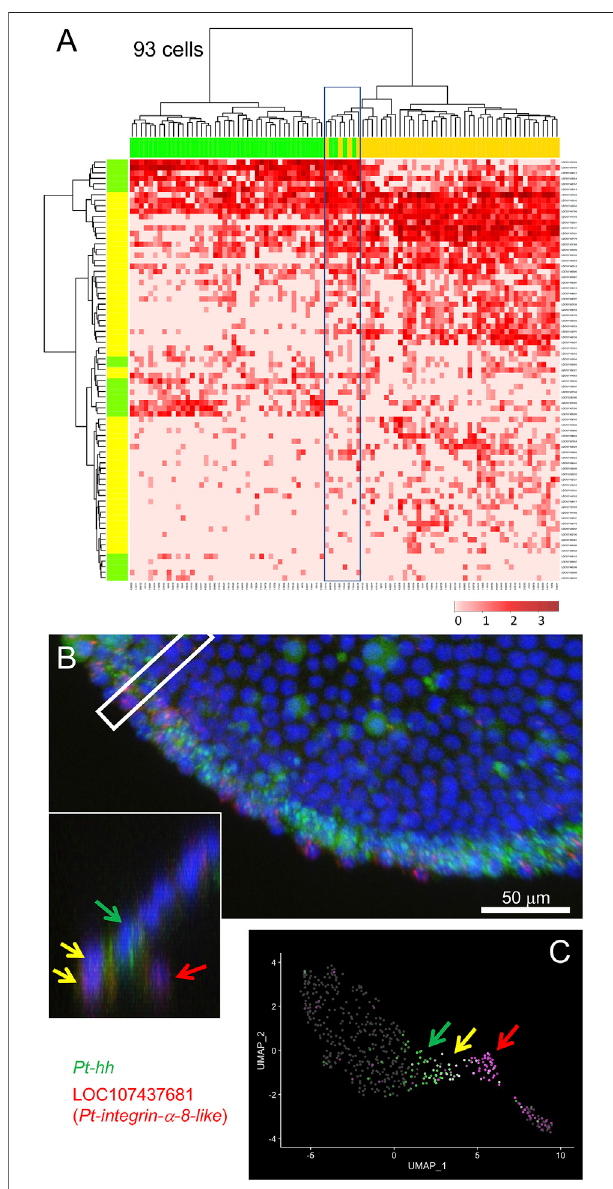
FIGURE 4 | Speci fi cation of mesodermal cells at the peripheral region. (A) Dendrograms of 93 presumptive peripheral ectodermal and mesodermal cells (top) and 77 peripheral and mesodermal marker genes (left) were constructedbyhierarchicalclusteringofthenormalized expressionlevel. Thebaronthetopdisplaystheclusterofthecellsshownin Figure2A :yellow, cluster 1 (mesoderm); green, cluster 2 (peripheral ectoderm). The bar on the leftshowsthegroupofgenes:yellow,mesodermalmarkers;green,peripheral markers which are the same genes shown in green in Figure 3 . The heatmap shows the normalized expression levels (color code in the bottom right). Boxed cells show relatively high-level expression of both mesodermal and peripheral markers. (B) Detection of Pt-hh (green) and LOC107437681 ( Pt- integrin alpha-8-like , red) transcripts using FISH at the peripheral region of the germdiscatlatestage5.Thecrosssectionoftheboxedregionisshowninthe inset. Scale Bar = 50 μ m. (C) Expression of the two genes visualized on the UMAP plot. In B and C, green arrows show Pt-hh- positive cells, red arrows show LOC107437681-positive cells, and yellow allows show double-positive